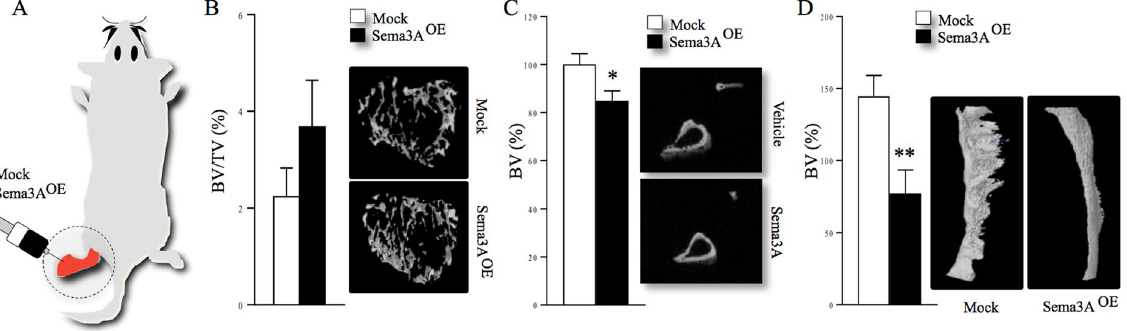
Figure 3. Osteosarcoma-derived Sema3A inhibits ectopic bone formation in vivo . ( A ) Graphic representation of para-tibial injection of human KHOS cells overexpressing Sema3A (Sema3A OE ) or control (mock) (n = 10, 16 days) in 5 week old female Rj: NMRI nude mice. ( B ) Bone volume (BV/TV, %) in the tumour-bearing tibia (dashed circle) from the experiments described in panel A. Representative photomicrographs of microCT scan of trabecular bone from the experiment described are shown on the right. Ectopic bone volume (BV %) in the tumour-bearing tibia ( C ) and fibula ( D ) from the experiments described in panels A-B. Representative photomicrographs of microCT scans of fibular ectopic bone from the experiment described are shown on the right. Data are mean ± SEM, n = 10 * p < 0.05, ** p <